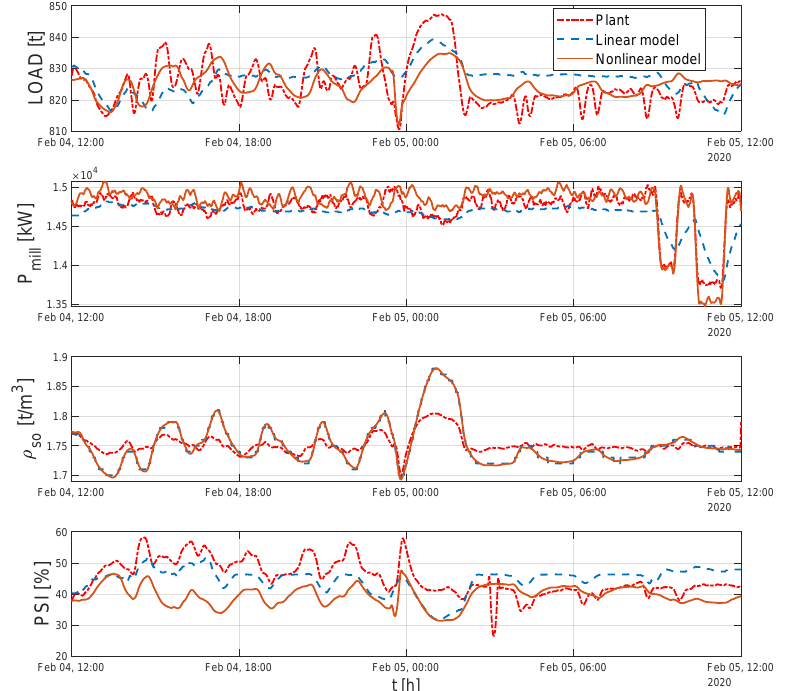
Figure 12. Comparison of the CV predictions using the linear and nonlinear models for the planned step test